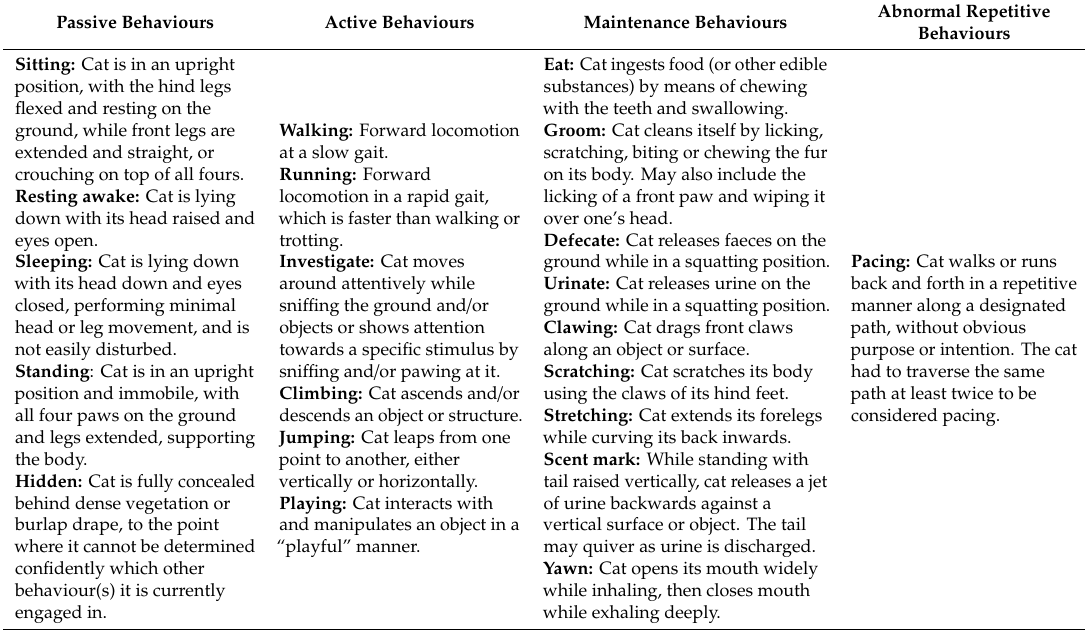
Table 3. Ethogram of serval behaviour, adapted from Stanton et al. [31]. Passive Behaviours Active Behaviours Maintenance